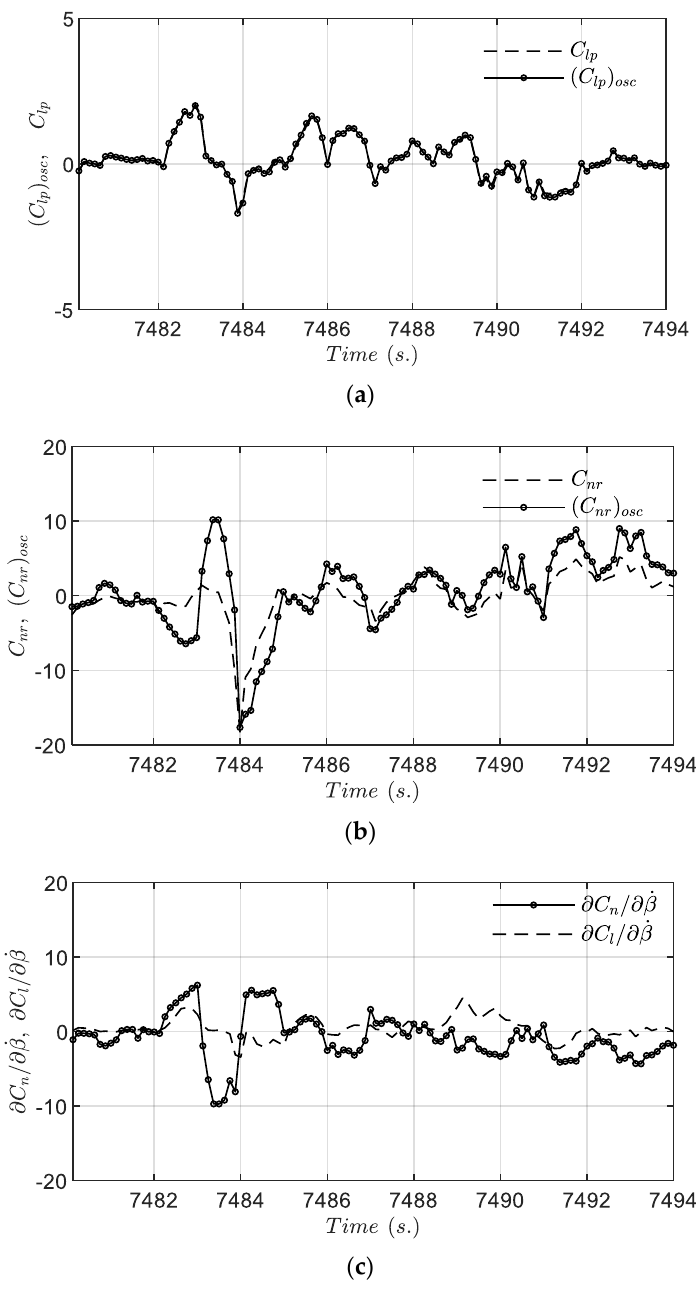
Figure 7. Time history of main lateral-directional oscillatory derivatives along the flight path. ( a ) Time history of ( C lq ) osc and C lq ; ( b ) Time history of ( C nr ) osc and C nr ; ( c ) The effects of -derivatives on C n and C r .